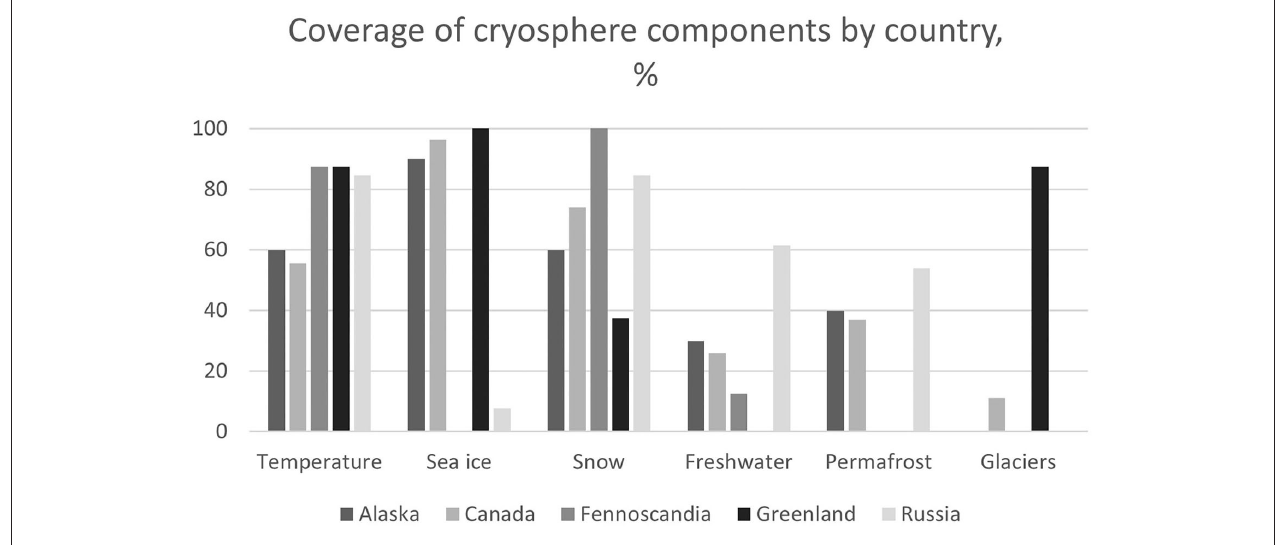
FIGURE 2 | Coverage of cryosphere components by country, % of total papers.